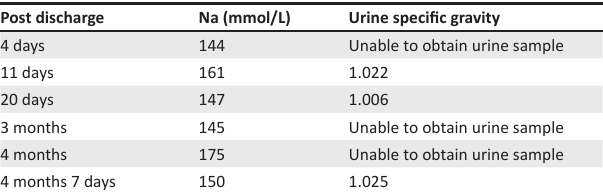
Table 5: Follow up serum sodium levels and urine specific